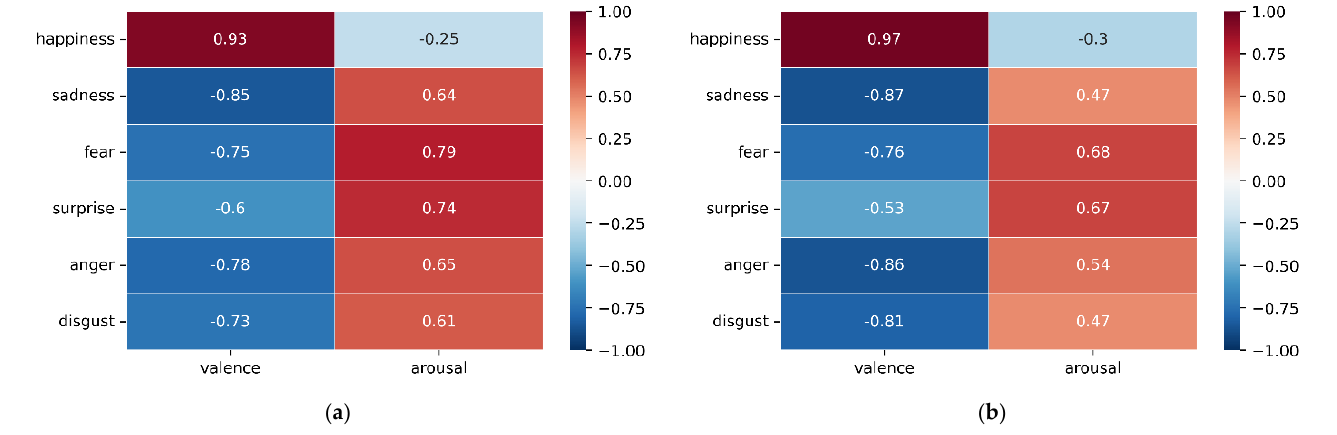
Figure 7. Correlations among 6 emotion norms (happiness, fear, sadness, surprise, anger, disgust) and 2 emotion dimensions (valence, arousal) in the NAPS BE dataset: ( a ) Pearson correlation coeffi- cient matrix ( r ); ( b ) Spearman’s rank matrix ( r s ).